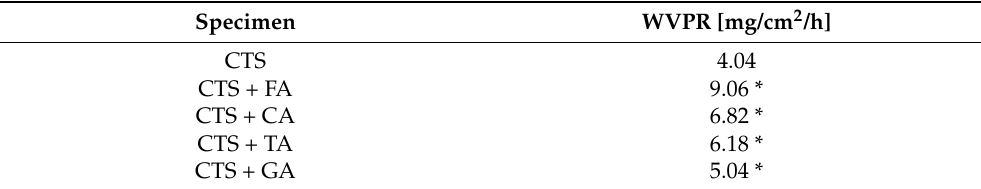
Figure 2. The weight change of calcium chloride grains after 1, 2, 4, 7, and 8 days (37 ° C) for samples based on chitosan modified by phenolic acids. Table 3. The water permeability recalculated to mg/cm 2 /h units (* significantly different from CTS— p <